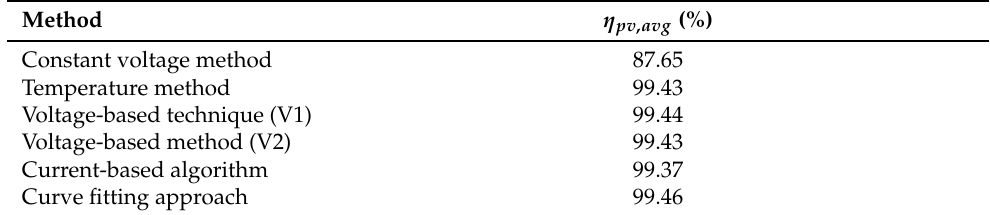
Table 3. Average efficiencies of the model-based MPPT techniques at step changes of